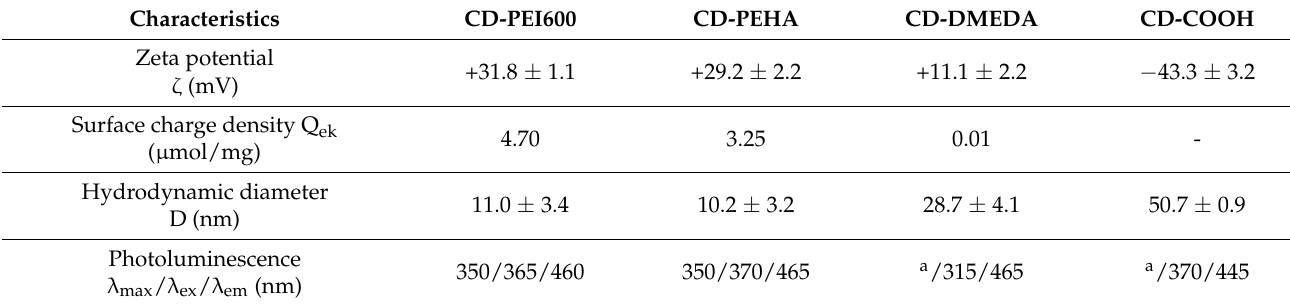
Table 1. Physicochemical characteristics of the CDs investigated